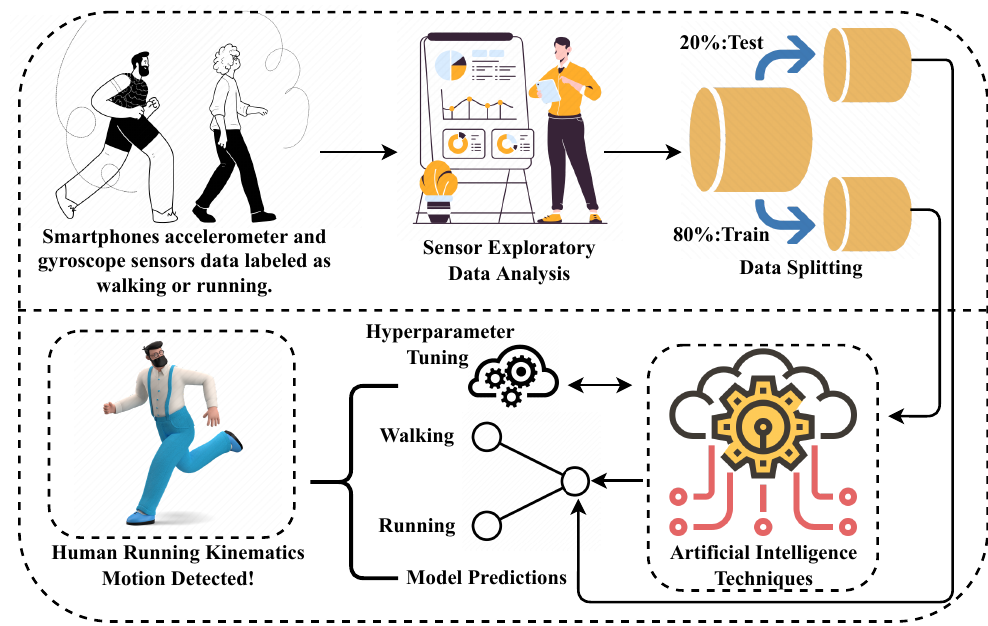
Figure 1. Methodological analysis of the proposed research study in the context of detection in human motion kinematics. Table 2. Descriptive analysis of the dataset features used for